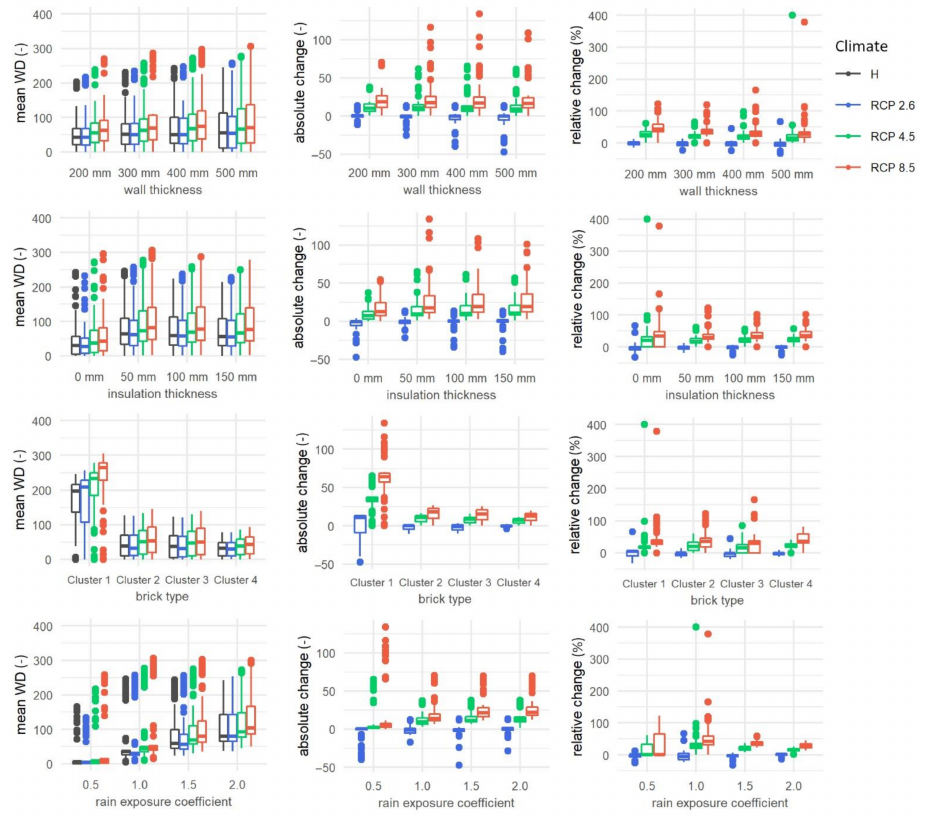
Figure 7. Mean value, mean absolute and mean relative change in the WD for the SW orientation per parameter variation: wall thickness, brick type, insulation thickness and rain exposure